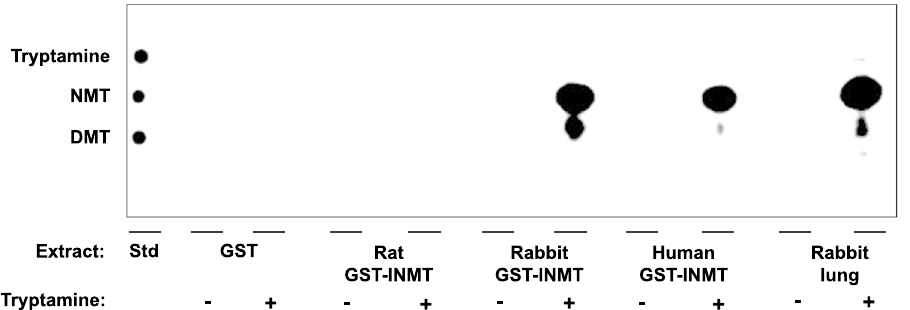
Figure 5. Rabbit and human, but not rat INMT methylate tryptamine to produce NMT and DMT. Phosphor imaging scan of radiometric enzyme assay products using recombinant GST-INMT fusion proteins following separation on silica gel plates using a mobile phase of N-butanol:acetic acid:water (12:3:5). A standard (Std) mixture containing tryptamine, NMT and DMT were clearly separated using these chromatography methods (left most lane). The standards showed respective R F values of 0.58, 0.49, and 0.39. Rabbit INMT, human INMT, and rabbit lung each showed two spots isographic with both NMT and DMT. For rabbit INMT, NMT R F = 0.48 DMT R F = 0.41. For human INMT, NMT R F = 0 48 and DMT R F = 0.41. For rabbit lung (positive control), NMT R F = 0.50 and DMT R F = 0.41. Neither empty vector GST preparations nor rat GST-INMT showed detectable products, which indicates a lack of methylation activity. Uncropped, unprocessed phosphor imaging scan of the same graph is included as Supplementary Figure S6.